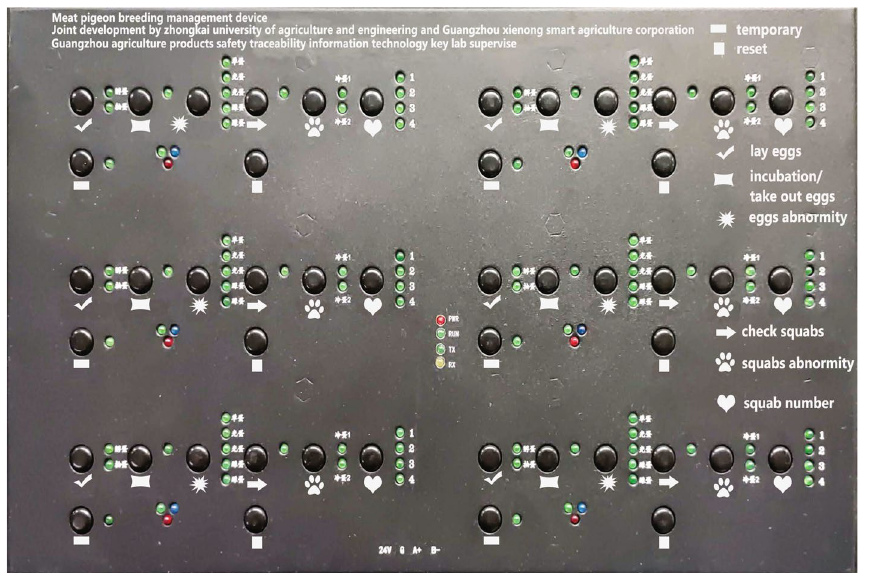
Figure 5. Farming information management